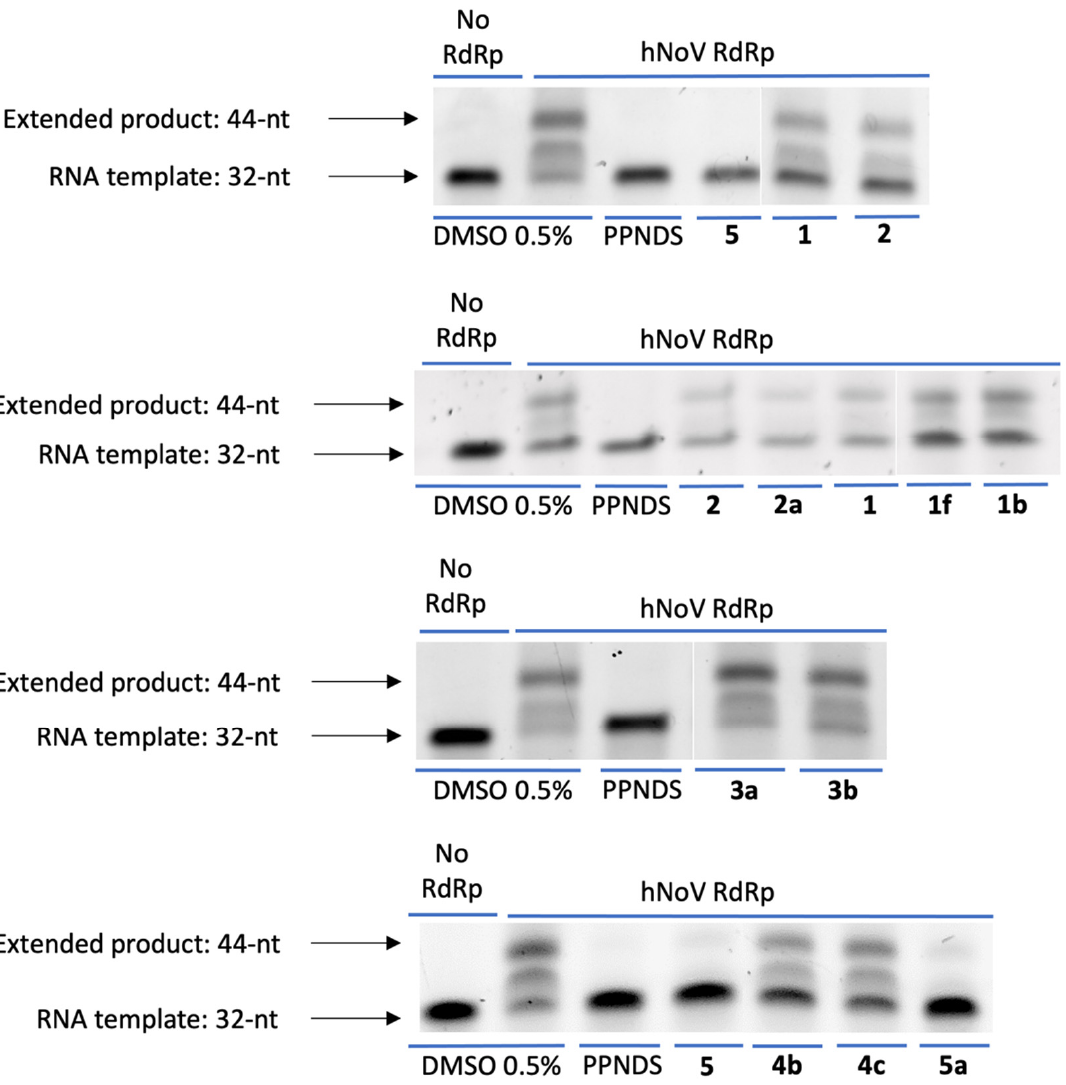
Figure 11. Counter-screen gel-shift assay to confirm HuNoV (GII.4) RdRp inhibitory activity for compounds 1 , 1b , 1f , 2 , 2a , 3a , b , 4b , c , 5 and 5a . The compounds were examined for inhibition of primed elongation activity. PE44-NoV RNA templates (32 nucleotides) were extended (44 nucleotides) by the RdRp in the absence of any test compounds (0.5% DMSO [vol/vol] negative control) or with test compounds at a fixed concentration of 100 µ M. PPNDS was used as positive controls (100 µ M) to demonstrate complete inhibition, and no RdRp was used as a negative control.